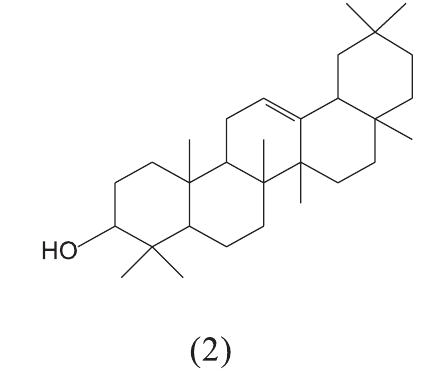
FIGURE 1 - Structures of α- (1) and β- amyrin